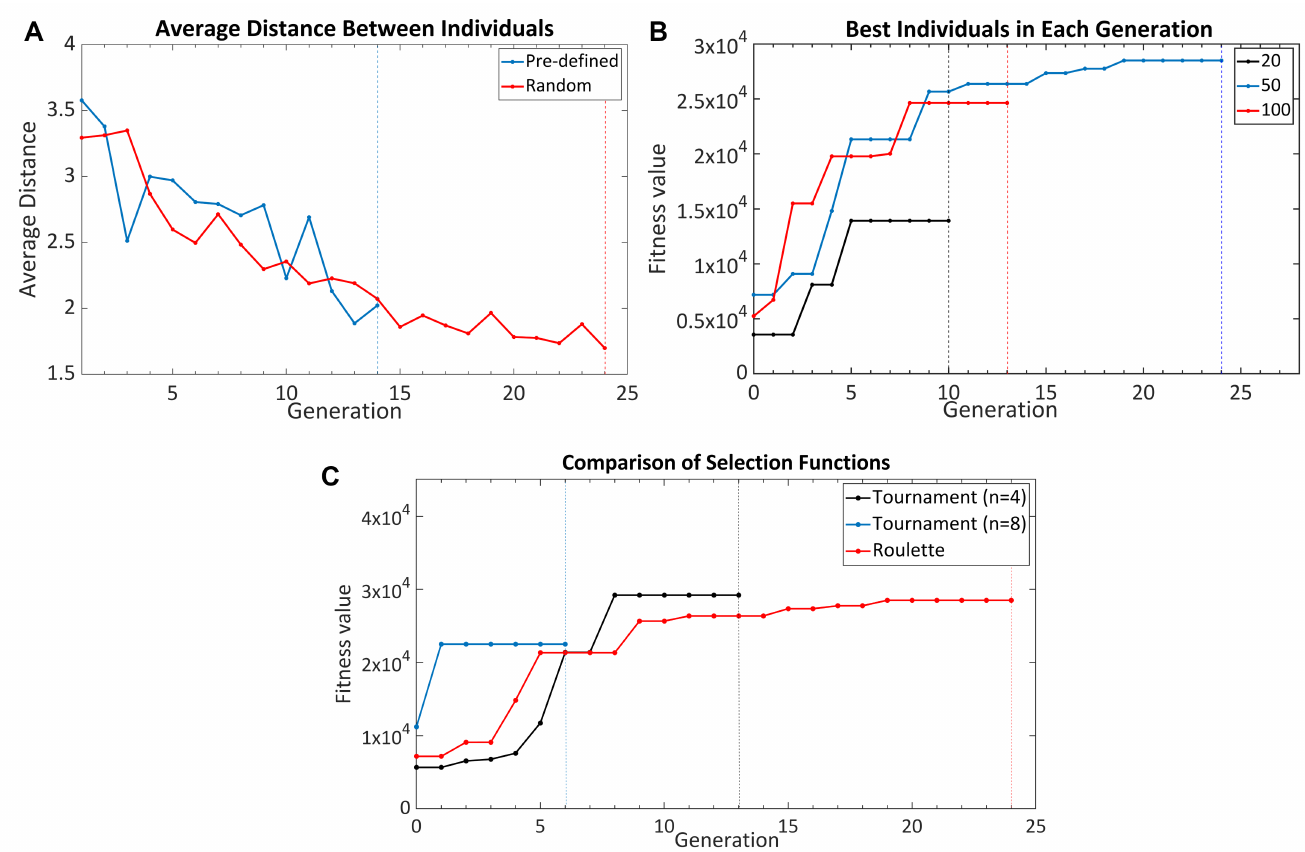
Figure 2. ( A ) The average distance between the individuals in each generation for different initial population functions. Since generating individuals randomly increases the population diversity, it is the recommended method when there is no prior information about the structure. ( B ) The fitness values obtained by GAs with different population sizes. According to the obtained results, the population size of 50 is the most suitable parameter for the SERS substrate optimization. ( C ) The fitness values obtained by GAs with different selection functions. Since the tournament function is affected by its parameters of n , the roulette wheel selection function is used for SERS substrate